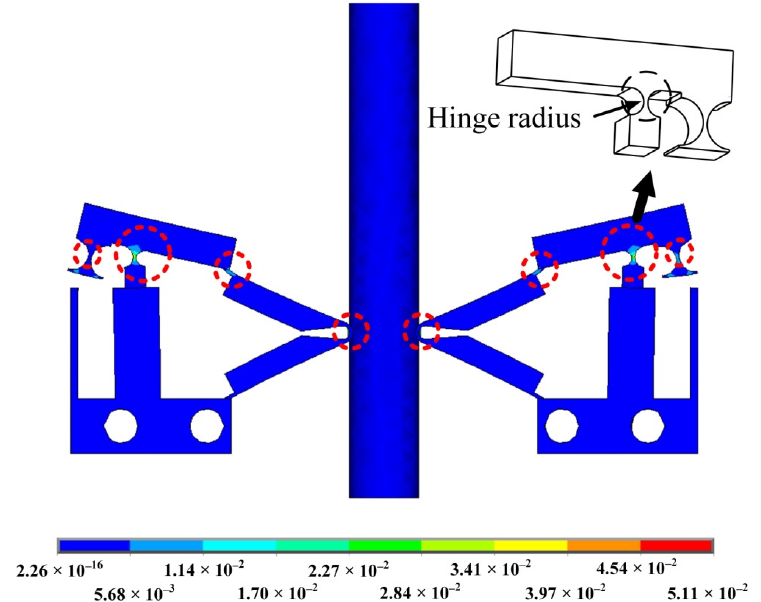
Figure 12. Stress distribution. Figure 13 is the parametric analysis diagram of the hinge radius. The left coordinate axis represents the displacement of the mover. The right axis represents the clamping force between the driving foot and the mover. The lower axis represents the radius of the hinge. According to the curve, it can be seen that with the increase in the hinge radius, the displacement of the actuator increases, and the clamping force between the driving foot and the actuator also increases. A hinge radius of 1.4 mm is selected.